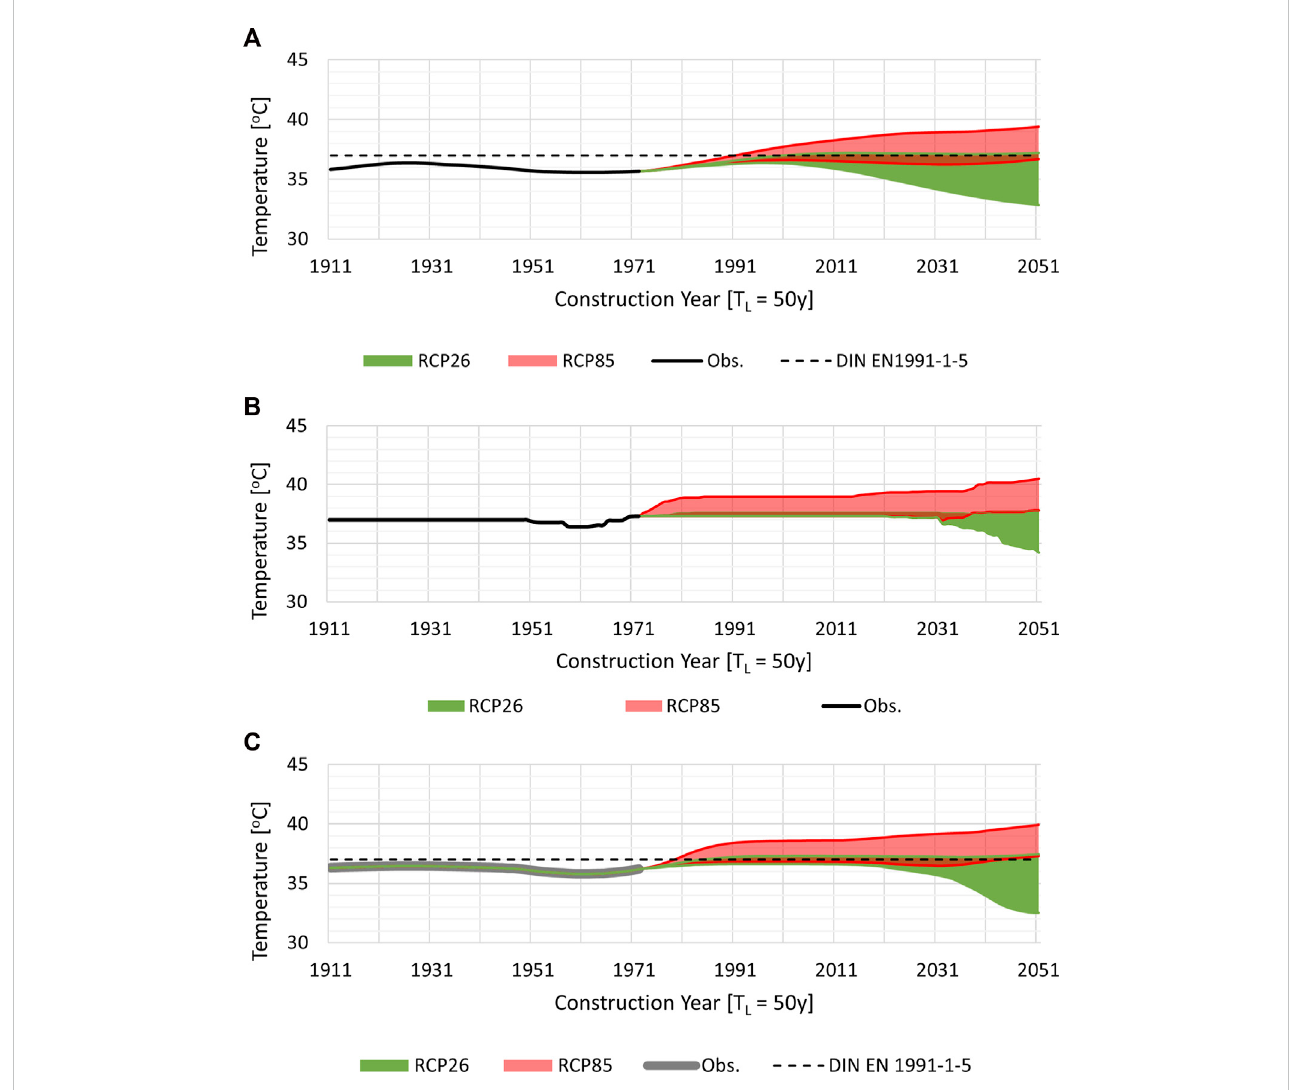
FIGURE 6 Comparison of the non-stationary characteristic values determined using different methods for a design working life of 50-years: (A) c k , mean with comparatively non-conservative values; (B) c k , max with comparatively conservative values; (C) c k , eq satisfying the code de fi ned exceedance probability in 50 years i.e., 1-(1-0.02) 50 .